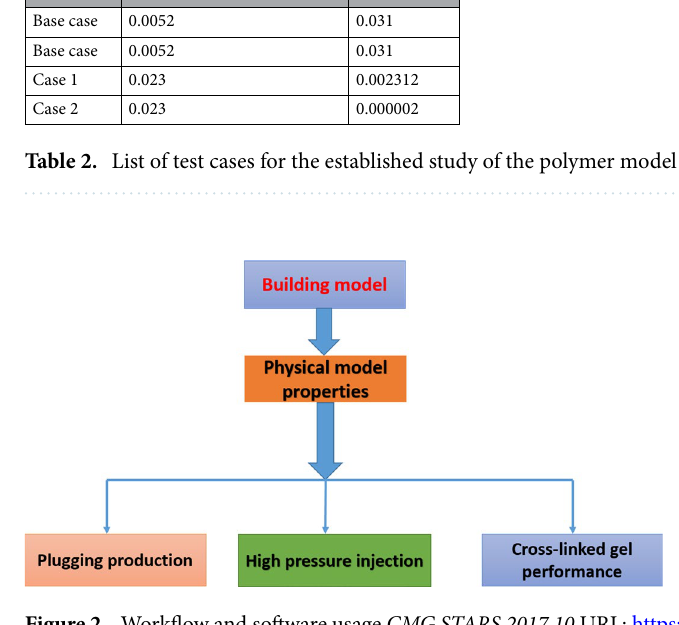
Figure 2. Workflow and software usage CMG STARS 2017.10 URL: https:// www. cmgl. ca/.